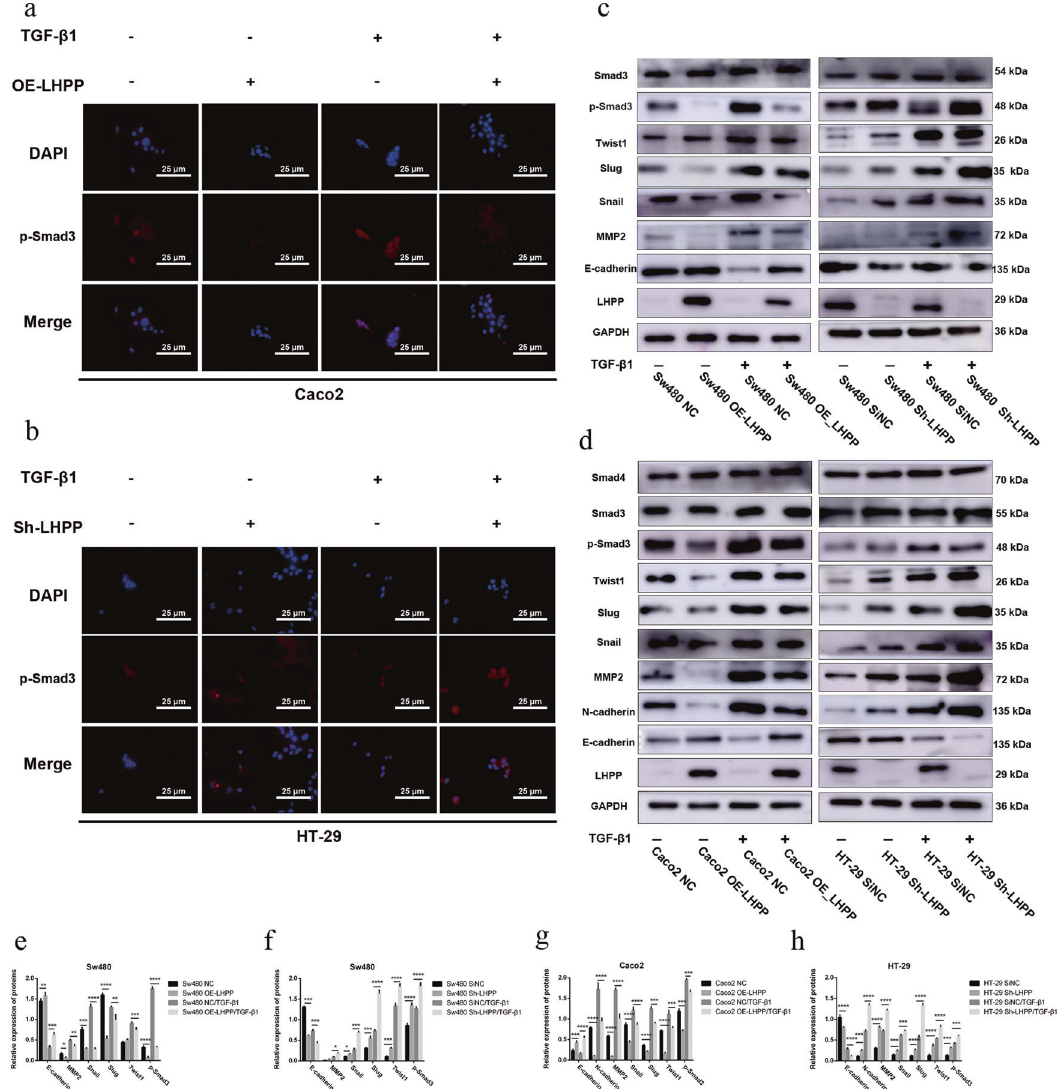
Fig. 5 LHPP blocks expression levels of key proteins in canonical TGF- β /Smad pathway. a , b Expression level of p-Smad3 was evaluated by using immuno fl uorescence assay after TGF- β 1 stimulation for 24 h, cell nuclei were counterstained with DAPI and observed under a fl uorescence microscope (scale bar: 25 μ m). c , d In response to TGF- β 1 stimulation, key molecules involved in the TGF- β /Smad classical signaling pathway were determined using western blot assay. e , f Relative expression levels of these proteins were calculated using Image J and Graphpad Prism 6 software. * P < 0.05, ** P < 0.01, *** P < 0.001, **** P < 0.0001.